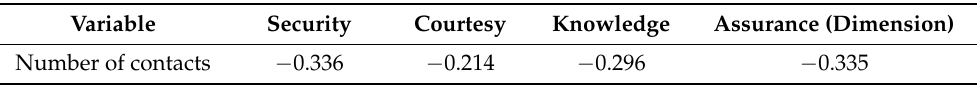
Table 11. Pearson correlation coefficients for the reliability dimension and its three features. All correlations are significant at the 0.01 level (2-tailed).